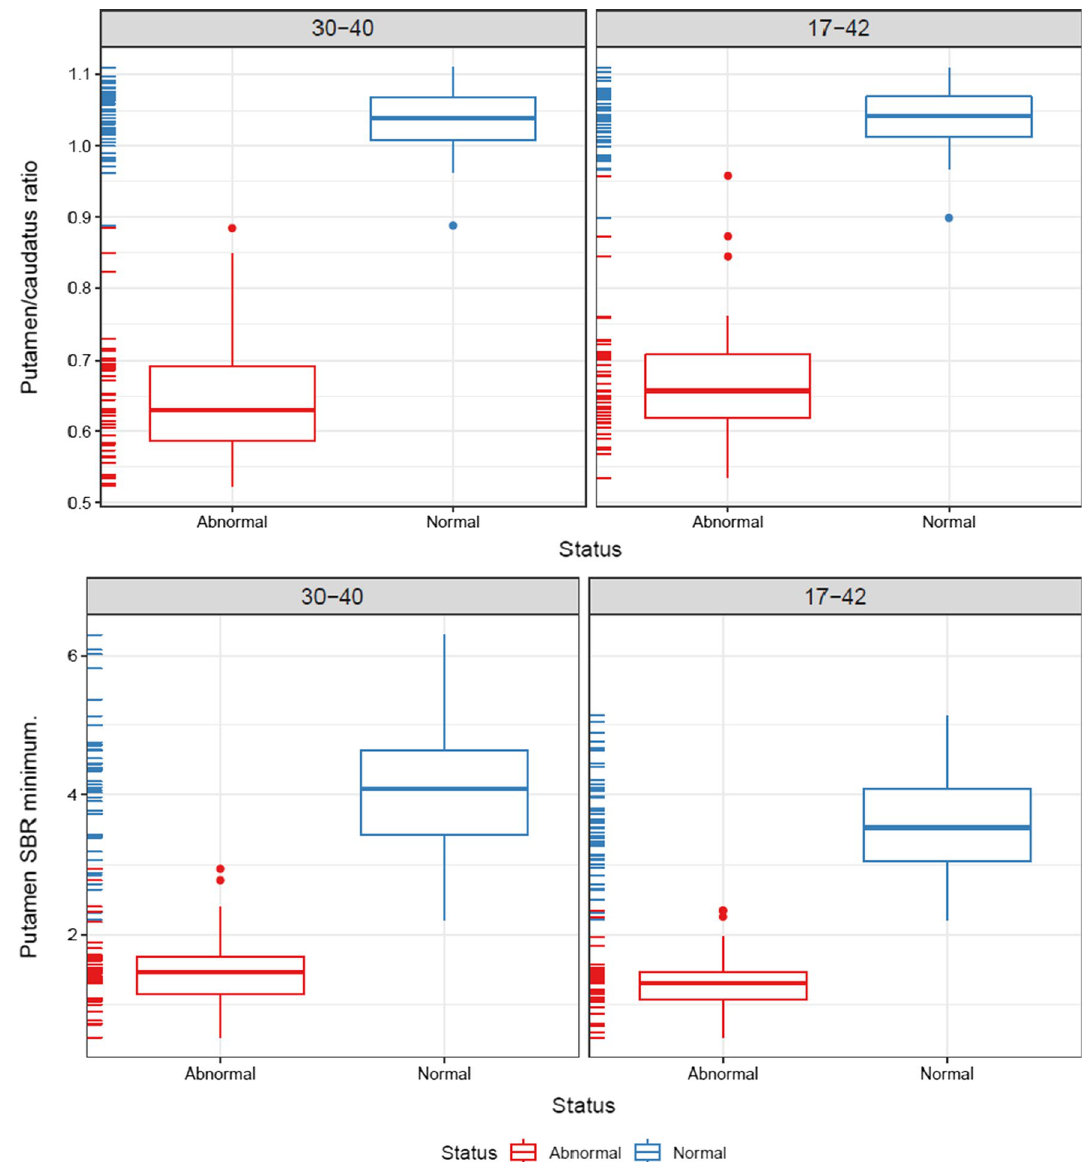
Fig. 3 Short versus longer acquisition protocol. Box-and-whisker plots of putamen/caudate nucleus ratio (top) and SBR for putamen (bottom; lowest SBR of right/left hemisphere) for 92 patients illustrating the difference between normal and abnormal patients. Six patients were excluded due to injected dose below 100 MBq. Left column: 30–40-min reconstruction, right column: 17–42 min. No significant difference in the ability to separate abnormal and normal scans was